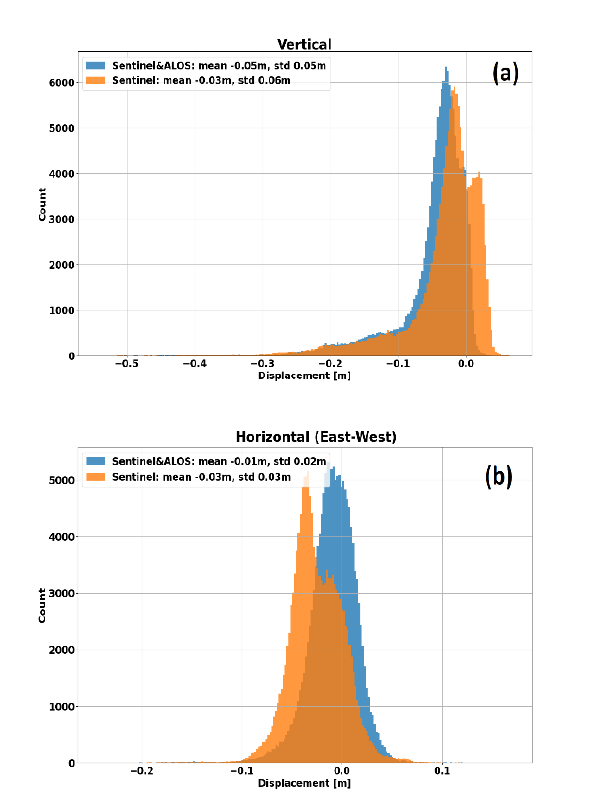
Figure 7. Cumulative deformation from DInSAR estimated for Sentinel-1A/B data only (orange) and for Sentinel-1A/B and ALOS-2 integrated aproach (blue) for vertical (a) and horizontal (east-west) component